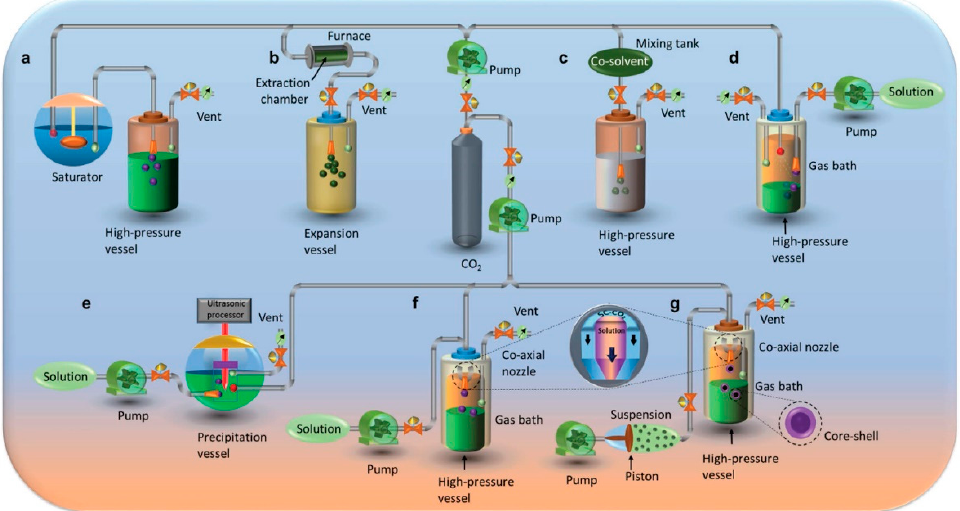
Figure 2. Conceptually distinct particle precipitation mechanisms are represented using scCO 2 : ( a ) Formation of particles from gas-saturated solutions (PGSS). ( b ) Expansion (rapid) of supercritical solutions (RESS). ( c ) Expansion (rapid) of a supercritical solution into a liquid solvent (RESOLV). ( d ) Precipitation using a compressed anti-solvent (PCA)/Aerosol solvent extraction system (ASES). ( e ) Supercritical antisolvent with enhanced mass transfer (SAS-EM). ( f ) Solution-enhanced dispersion by supercritical fluids (SEDS). ( g ) Suspension-enhanced dispersion by supercritical fluids (SpEDS) [28].